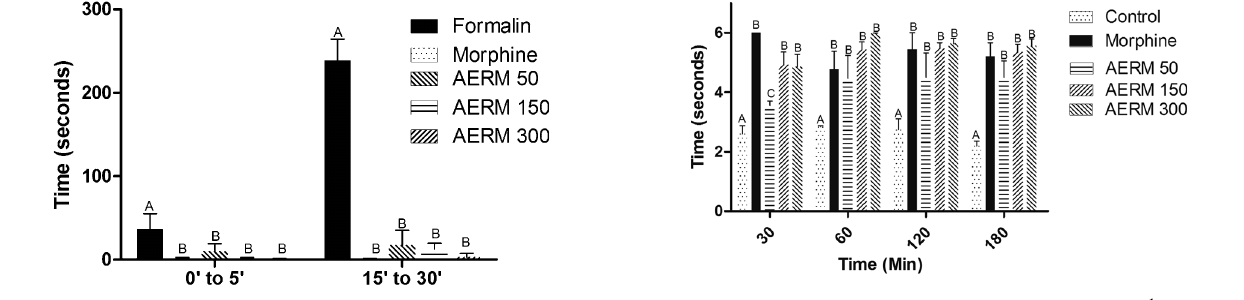
Fig. 3 Analgesic effect of AERM (50, 150 and 300 l g (cid:2) kg - 1 ) on